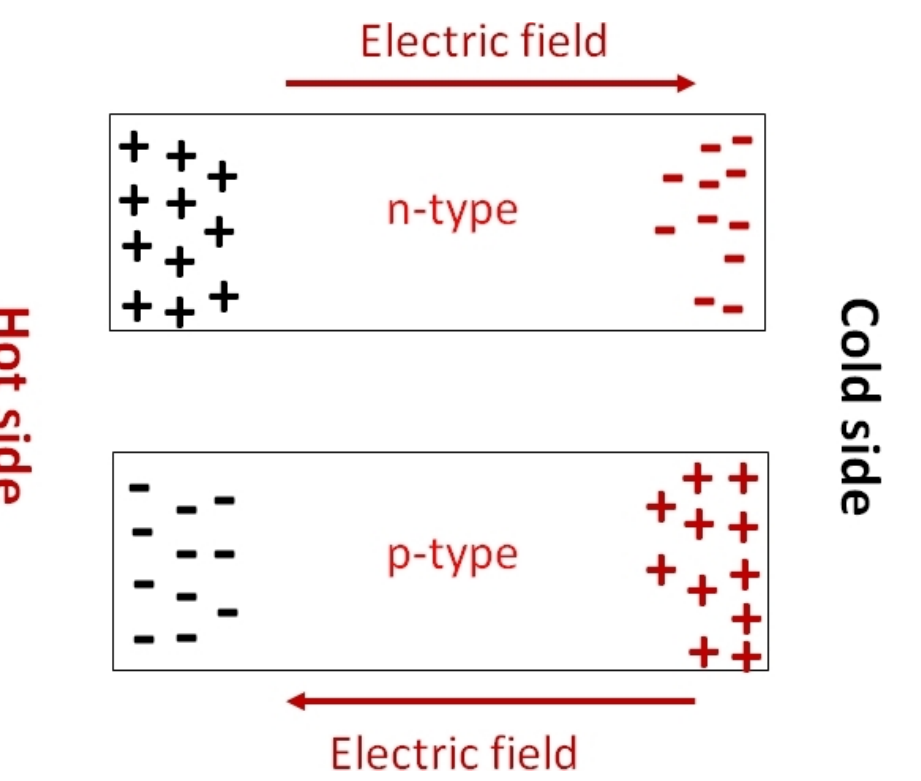
Figure 24. Schematic representation of the charge carrier motion under temperature gradient showing that the Seebeck effect can determine whether the conduction is p- or n-type.